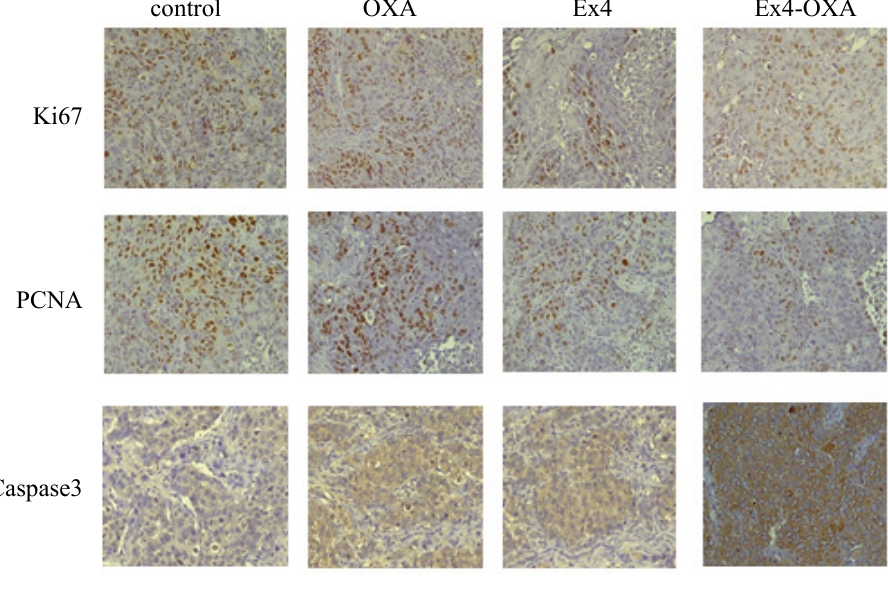
Figure 10. Tumor proliferation and apoptosis in different